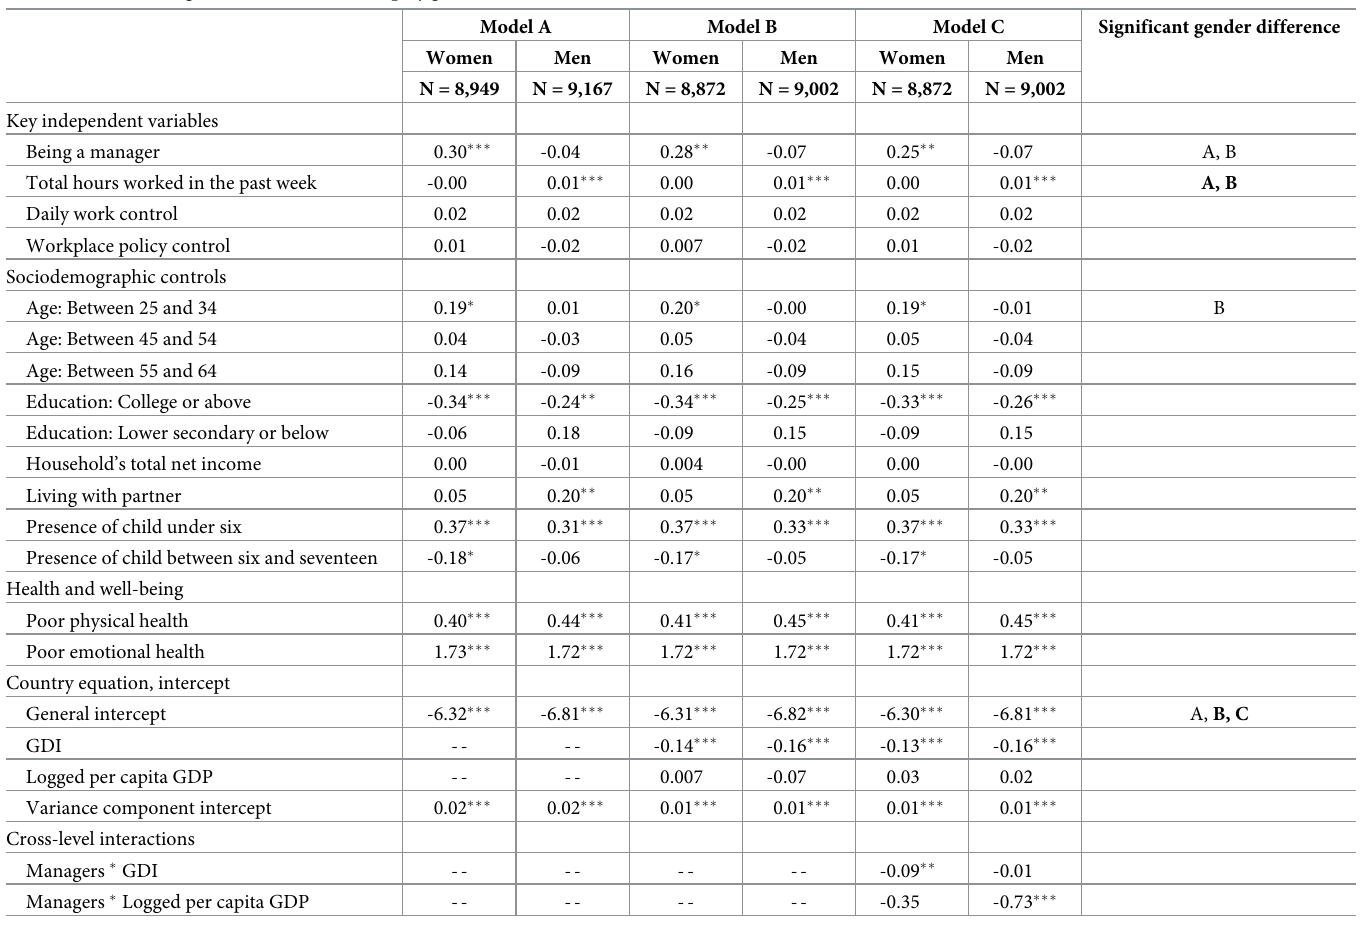
Table 3. Multilevel logit models of restless sleep by